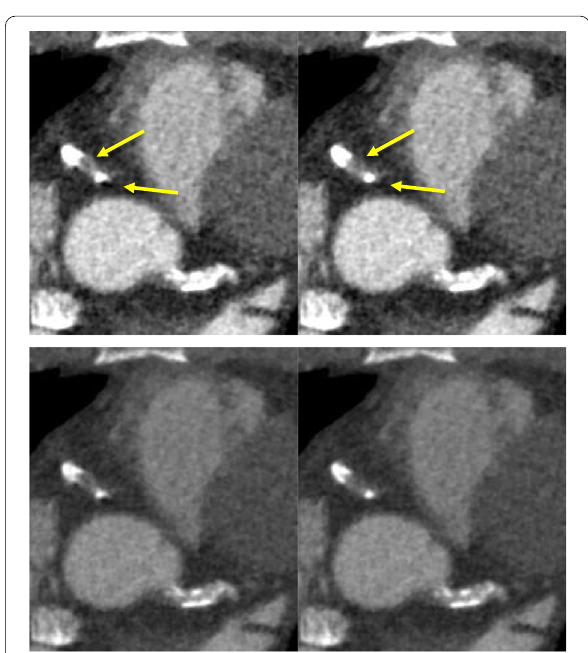
Fig. 7 CCTA exam (63 bpm, 70% R-R phase) with two calcifications and the effect of motion correction. Left: Without motion correction; Right: With motion correction. Top row W/L: 900/200; Bottom row W/L: 1600/400 (Credit: